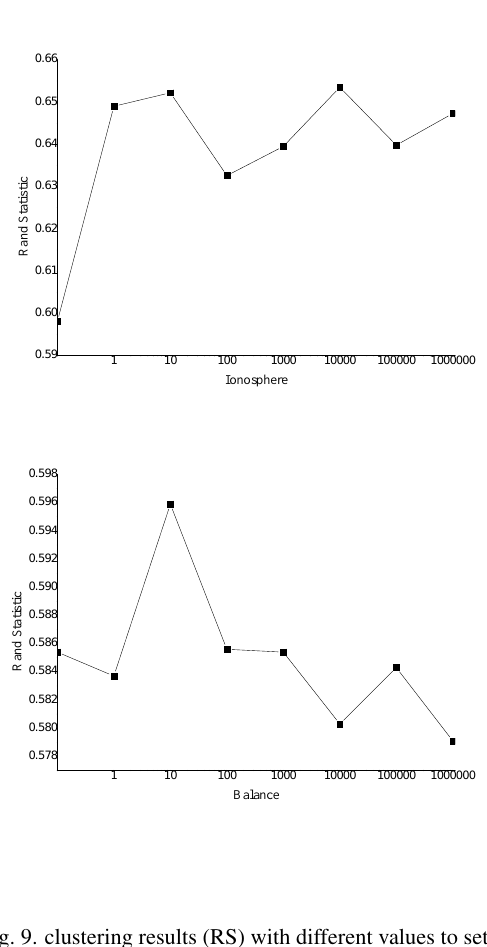
Fig. 9. clustering results (RS) with different values to set